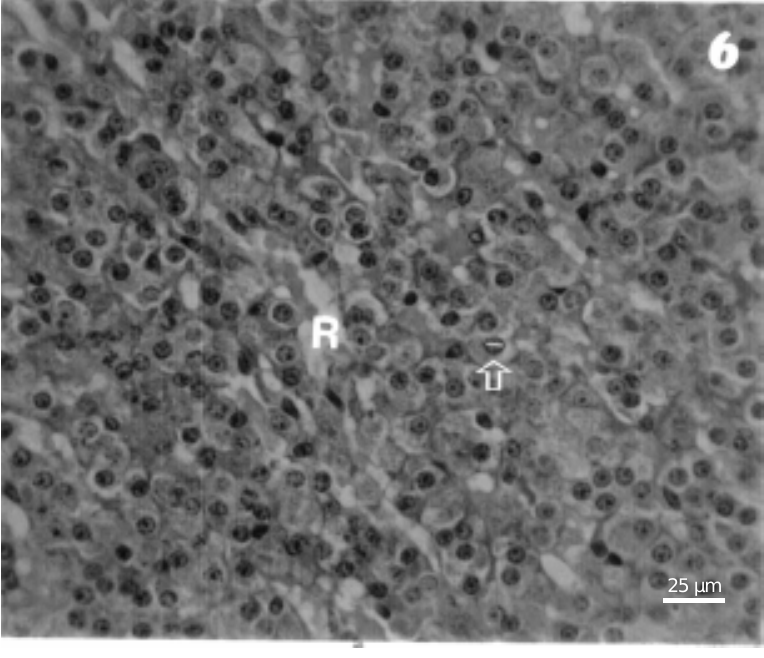
Table 2 - Seasonal variation of nuclear diameter in adrenal cortex of